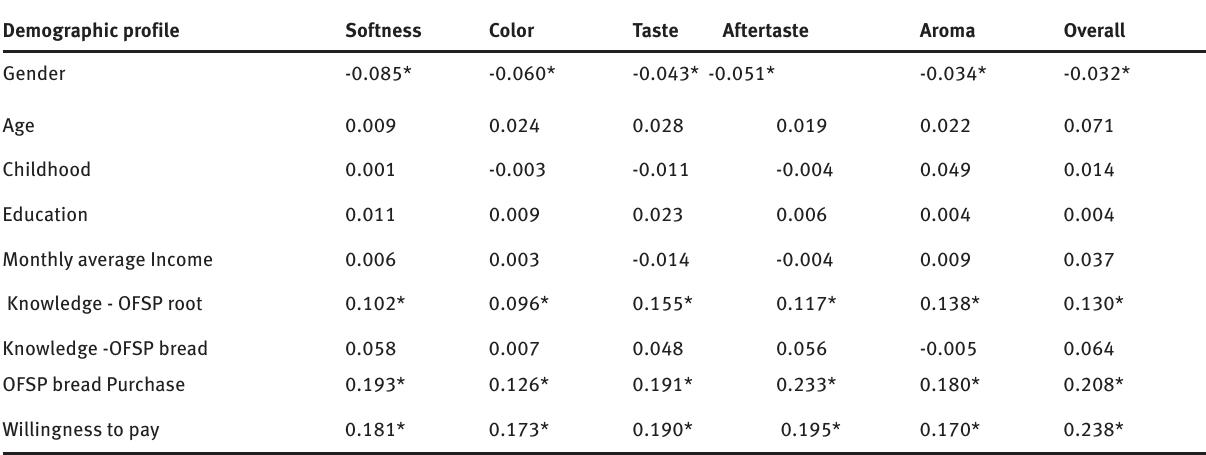
Table 4: Spearman’s correlation values showing relationship between respondents’ demographics and sensory attributes of OFSP bread